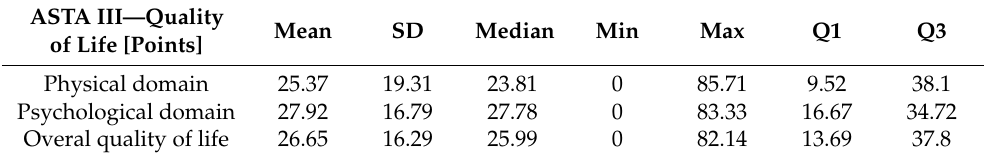
Table 2. Quality of life (ASTA III questionnaire).